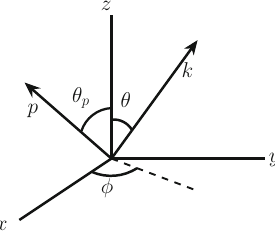
Fig. 1 Choice of reference frame for computing the various form fac- tors associated with the general structure of gauge boson 2-point func- tions. The magnetic field is along z -direction